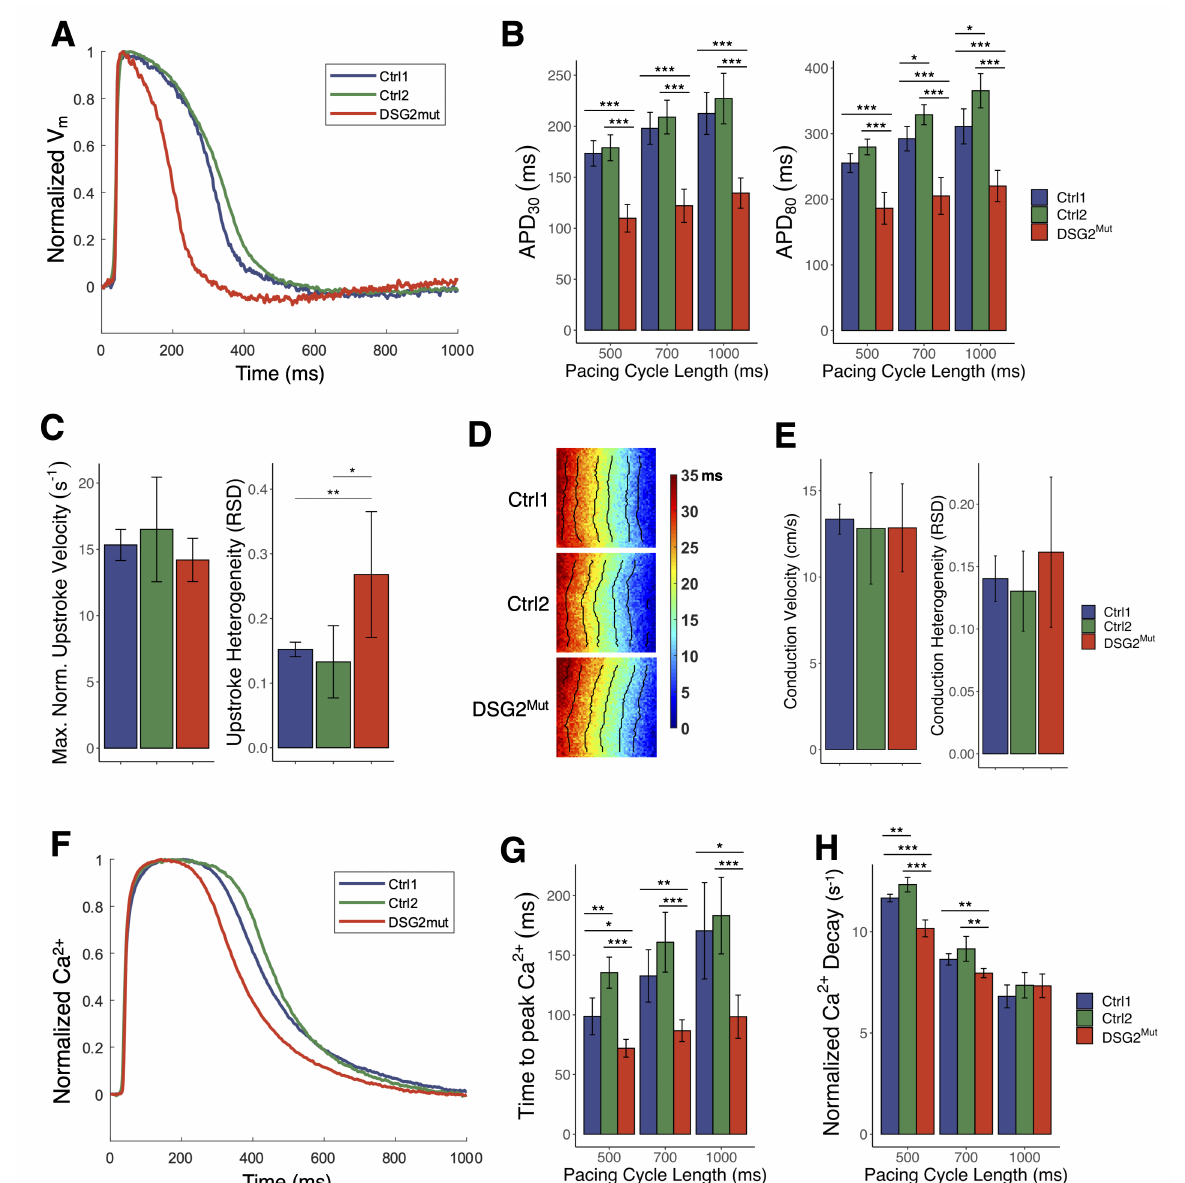
Figure 6. Action potential characteristics of hiPSC-CM monolayers measured via optical mapping. ( A ) Representative traces of normalized transmembrane potential (V m ). ( B ) Action Potential Duration (APD) measured at 30% and 80% repolarization. ( C ) Relative upstroke velocity measured at 1000 ms pacing and spatial heterogeneity of upstroke velocity, calculated as the relative standard deviation (RSD) of all measurements within each sample. ( D ) Activation maps with isochrone lines spaced 5ms apart. ( E ) Mean conduction velocity and conduction heterogeneity measurements at 1000 ms pacing. ( F ) Representative normalized calcium traces. ( G ) Time-to-peak Ca 2+ . ( H ) Ca 2+ decay rate, measured using normalized data. V m mapping ( B – E ): Ctrl1 ( n = 8), Ctrl2 ( n = 13) DSG2 Mut ( n = 9). Ca 2+ mapping ( G,H ): Ctrl1 ( n = 10), Ctrl2 ( n = 7), DSG2 Mut ( n = 9). * p < 0.05; ** p < 0.01, *** p <